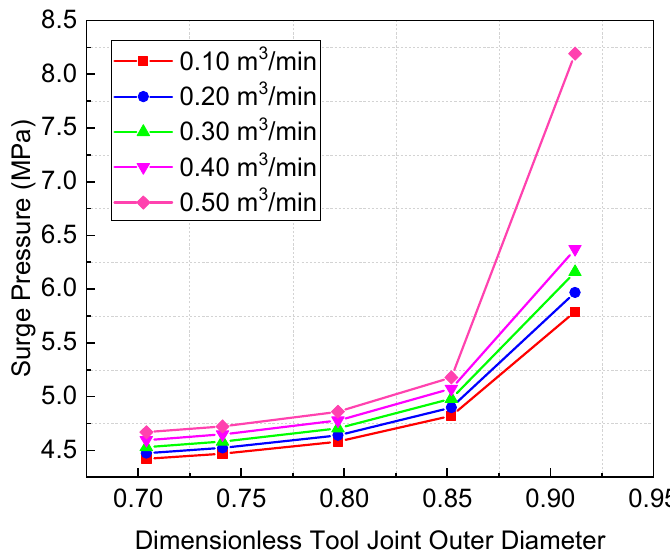
Figure 15. The relationship between the surge pressure and the dimensionless tool joint outer diameter. Figure 16 describes the relationship between the surge pressure difference and the dimensionless joint outer diameter (surge pressure difference = surge pressure when the joint exists—surge pressure when the joint does not exist). It can be seen from Figure 16 that the values of the surge pressure difference were all positive values, indicating that the existence of the joint increases the surge pressure. Moreover, the surge pressure was increased by a maximum of 76% compared to the surge pressure that did not consider the joint’s